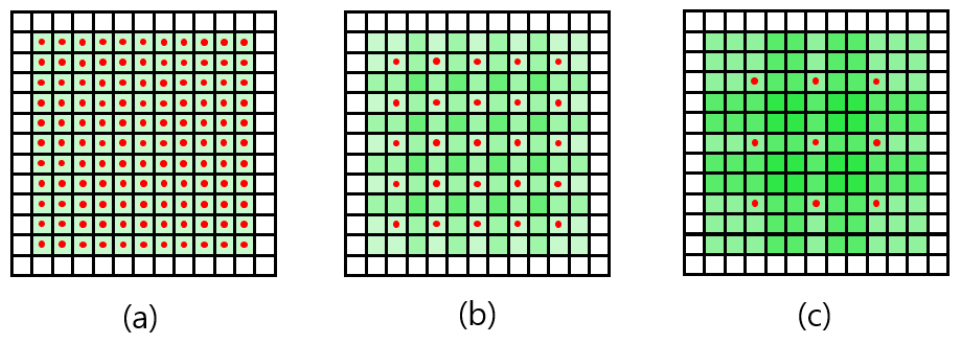
Figure 1. Dilated convolution with 11 × 11 RF. ( a ) General convolution or convolution with DR value of 1; ( b ) Convolution with DR of 2; ( c ) Convolution with DR of 3.